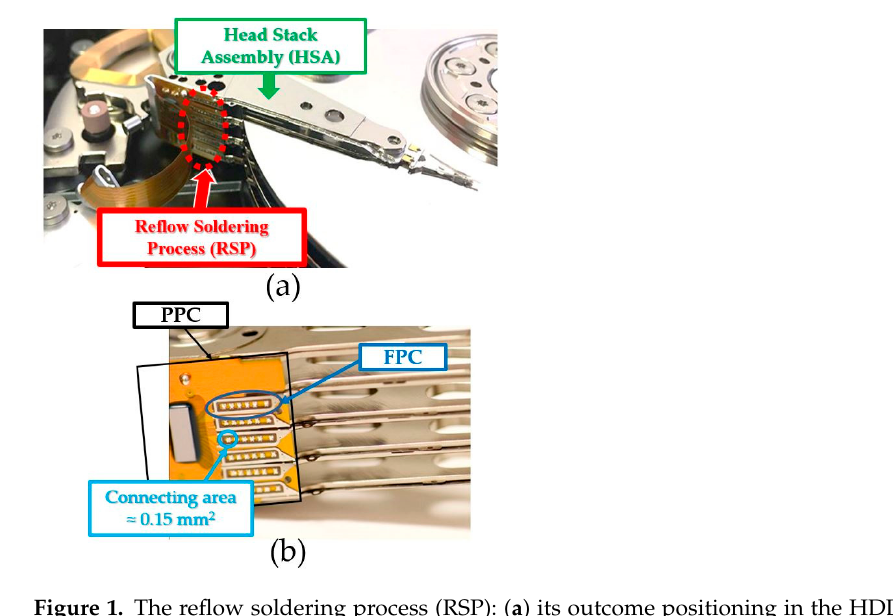
Figure 1. The reflow soldering process (RSP): ( a ) its outcome positioning in the HDD and ( b ) an enlarged picture.